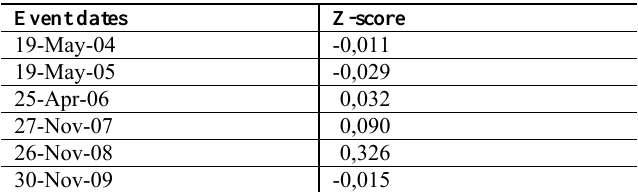
Table 1: Event dates and corresponding Z-score statistics for an event study with a 1-day event